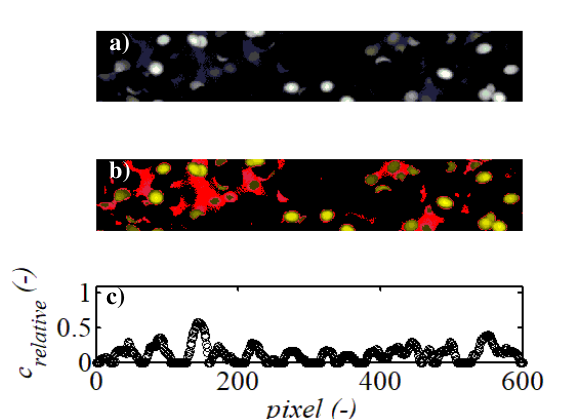
Fig. 4. Example of analyse part of image; a) raw image, b) recognizing area, c) relation of white particles to total concentration in each column of picture